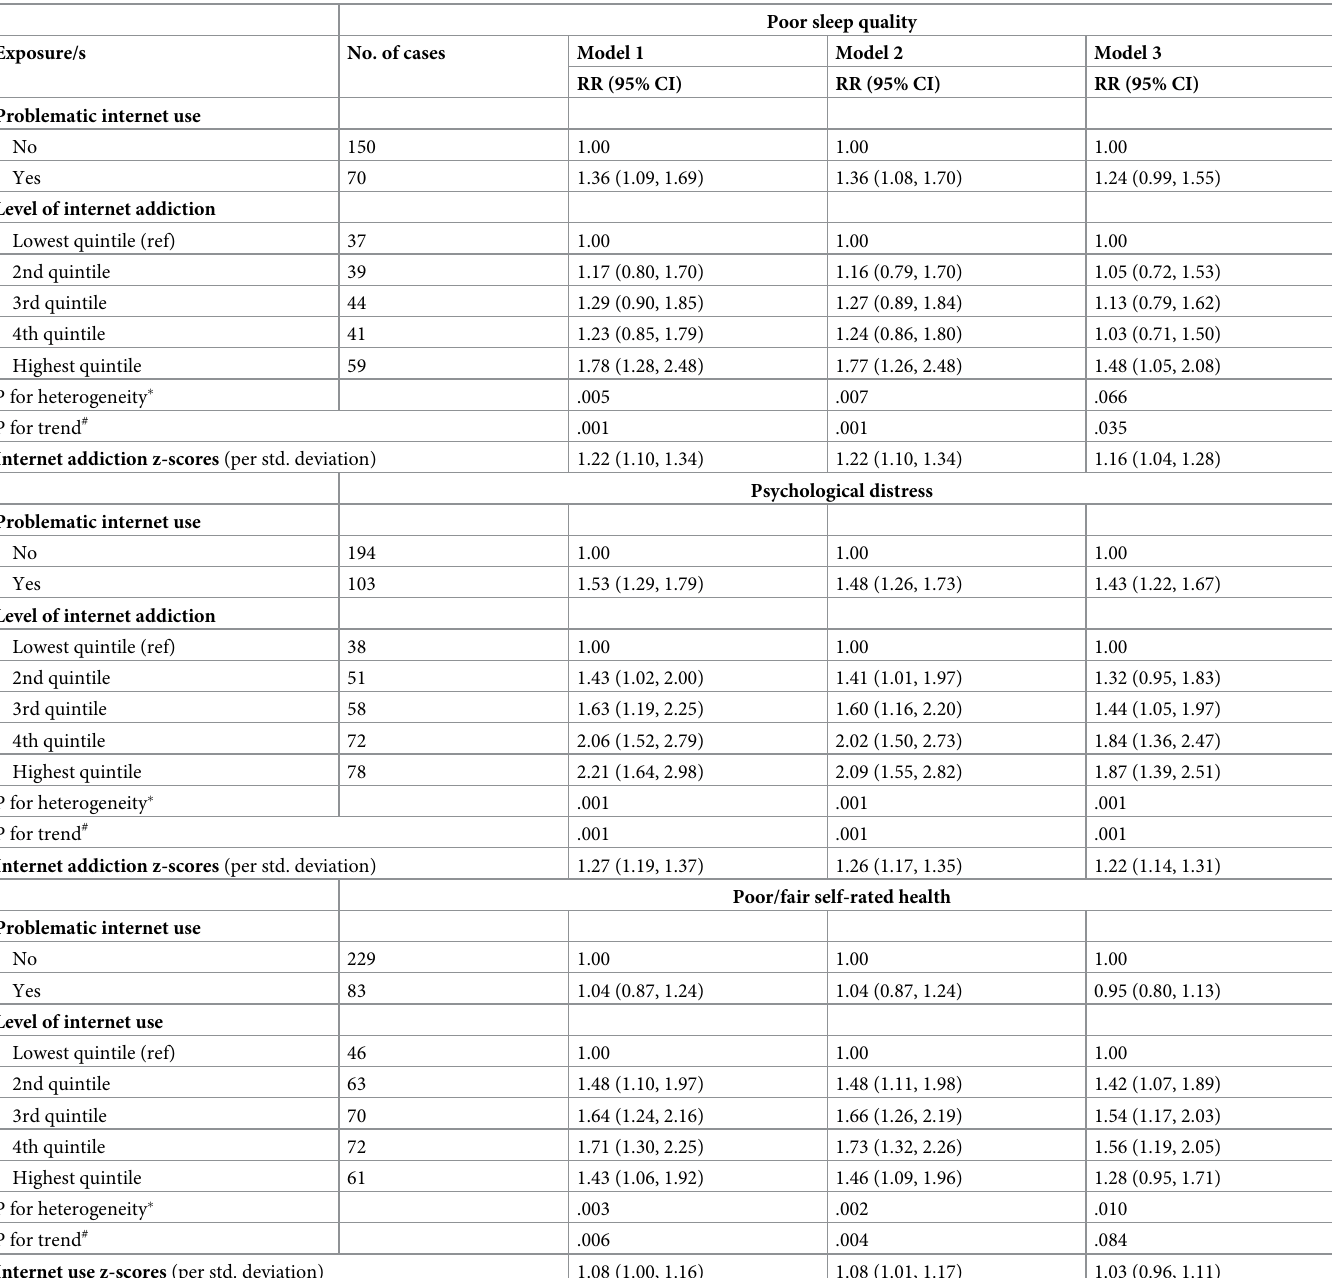
Table 3. Poisson regression analysis of the associations of internet addiction with poor sleep quality, psychological distress, and self-rated health (n =